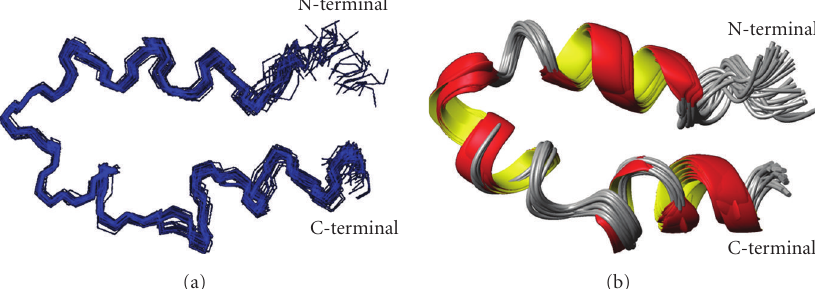
Figure 7: (a) Ensemble of DYANA 30 best models of the Zn 2+ -ACE C (37) (corresponds to His 958 - Ala 994 of the human somatic form), calculated with NMR data. (b) Ribbon diagram of Zn 2+ -ACE C (37)